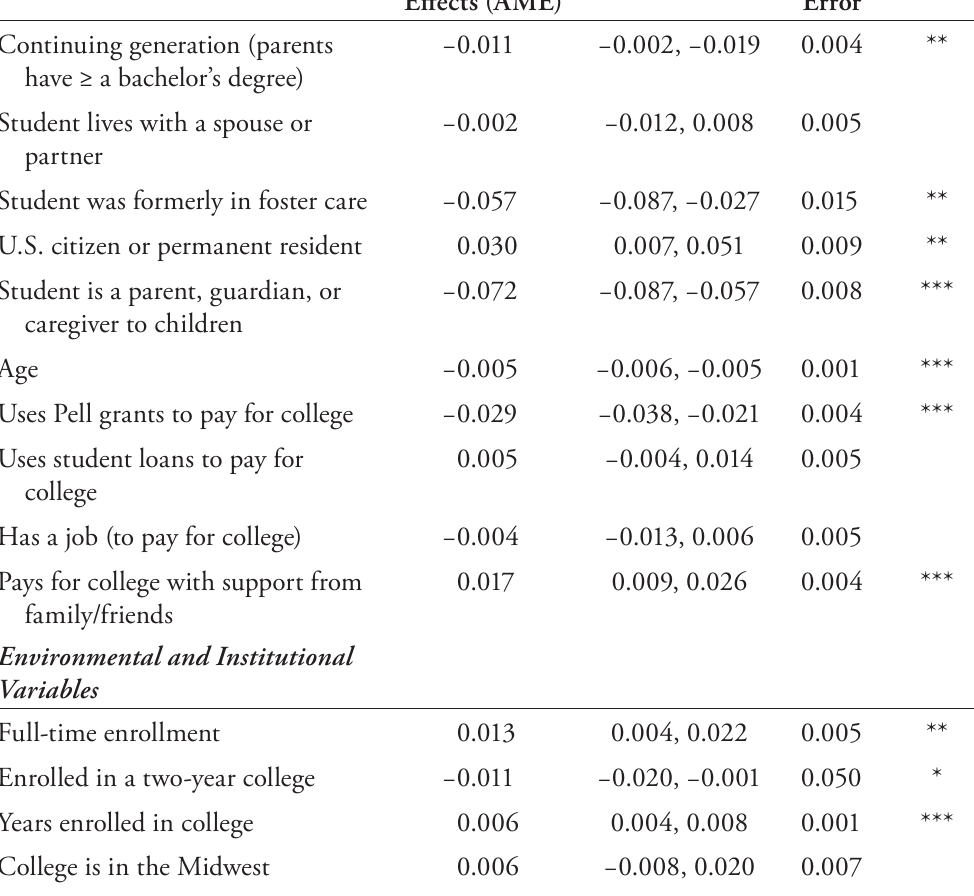
Table 3. Results of the Logistic Regression for Generalized Anxiety Disorder (GAD) ( continued